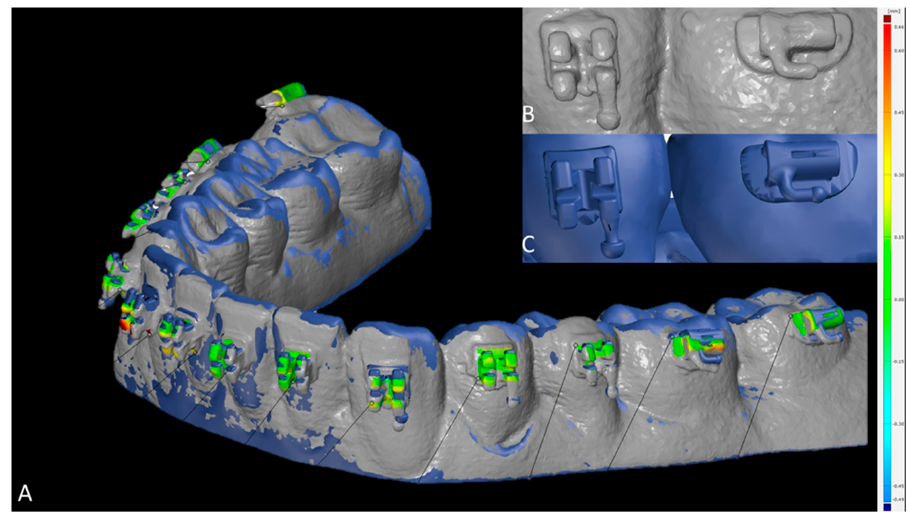
Figure 4. Measurement of the bracket transfer accuracy with GOM software. ( A ) Superimposed study models scanned with intraoral scanner (SMtest-IO) visualized in grey and reference study models (SMref) visualized in blue; distances are coded by heatmap coloring. ( B ) Scanned brackets from SMtest-IO in higher magnification. ( C ) Original brackets from SMref in higher magnification.